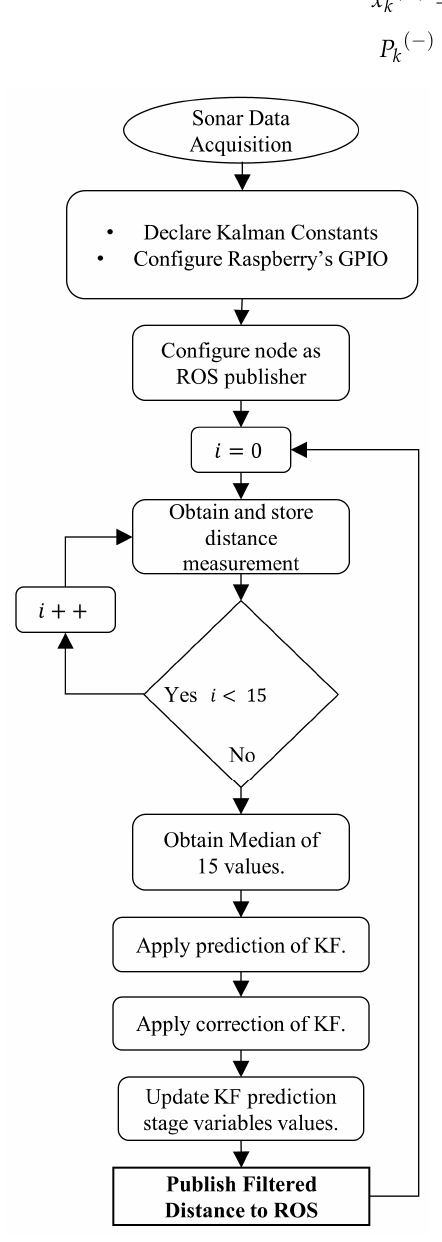
Figure 1. Ultrasonic sensor data acquisition flowchart and filtering strategy.